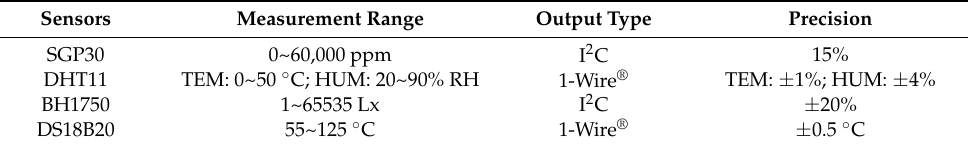
Table 1. Parameters of